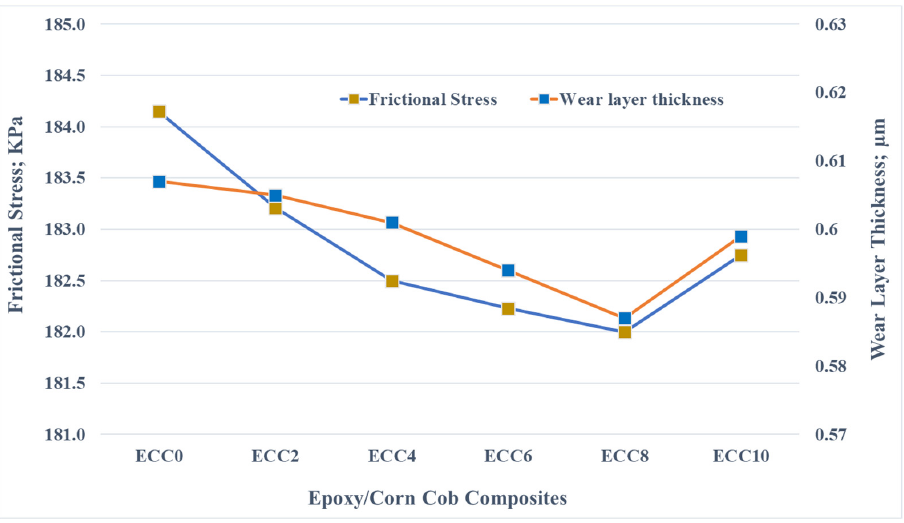
recorded during the evaluation of the mechanical characterization.